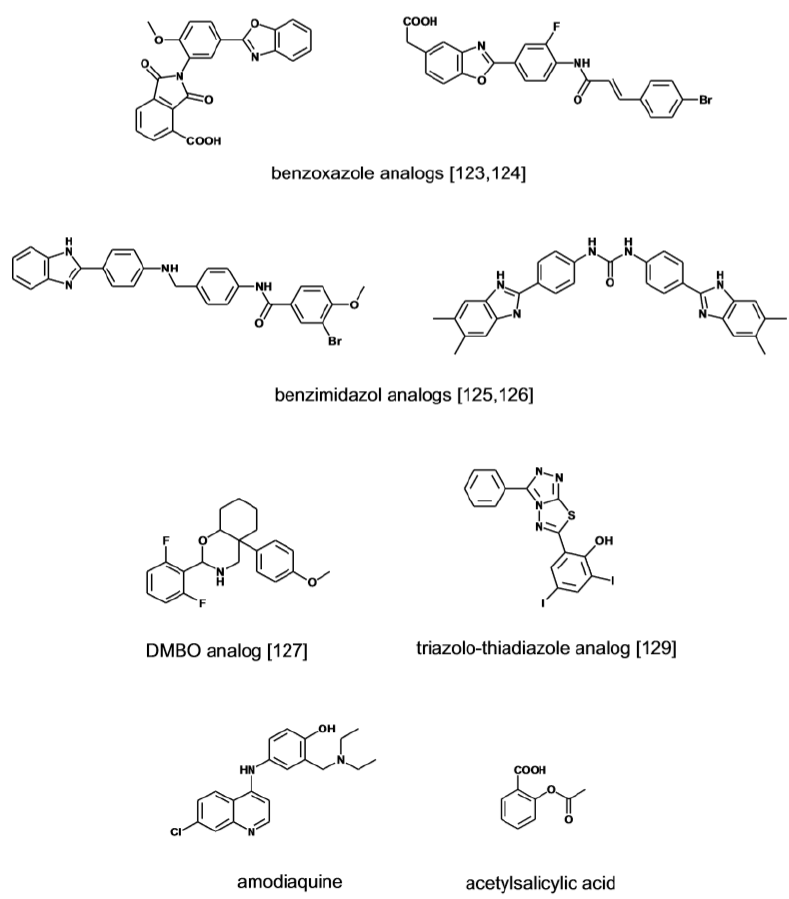
Figure 8. Heparanase inhibitors. Small molecular weight non-carbohydrate heparanase inhibitors. Structures redrawn from refs [123–127] and [129].